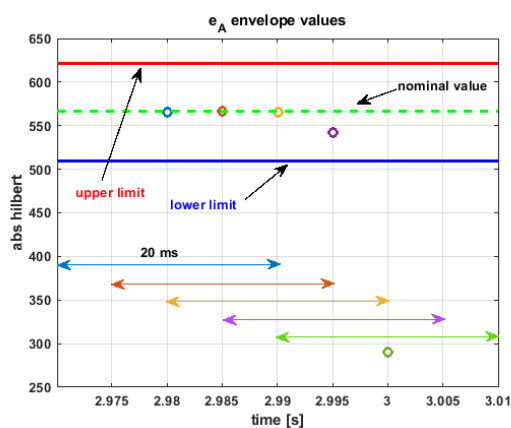
Figure 10. Point of common coupling (PCC) voltage envelope middle values (circles).